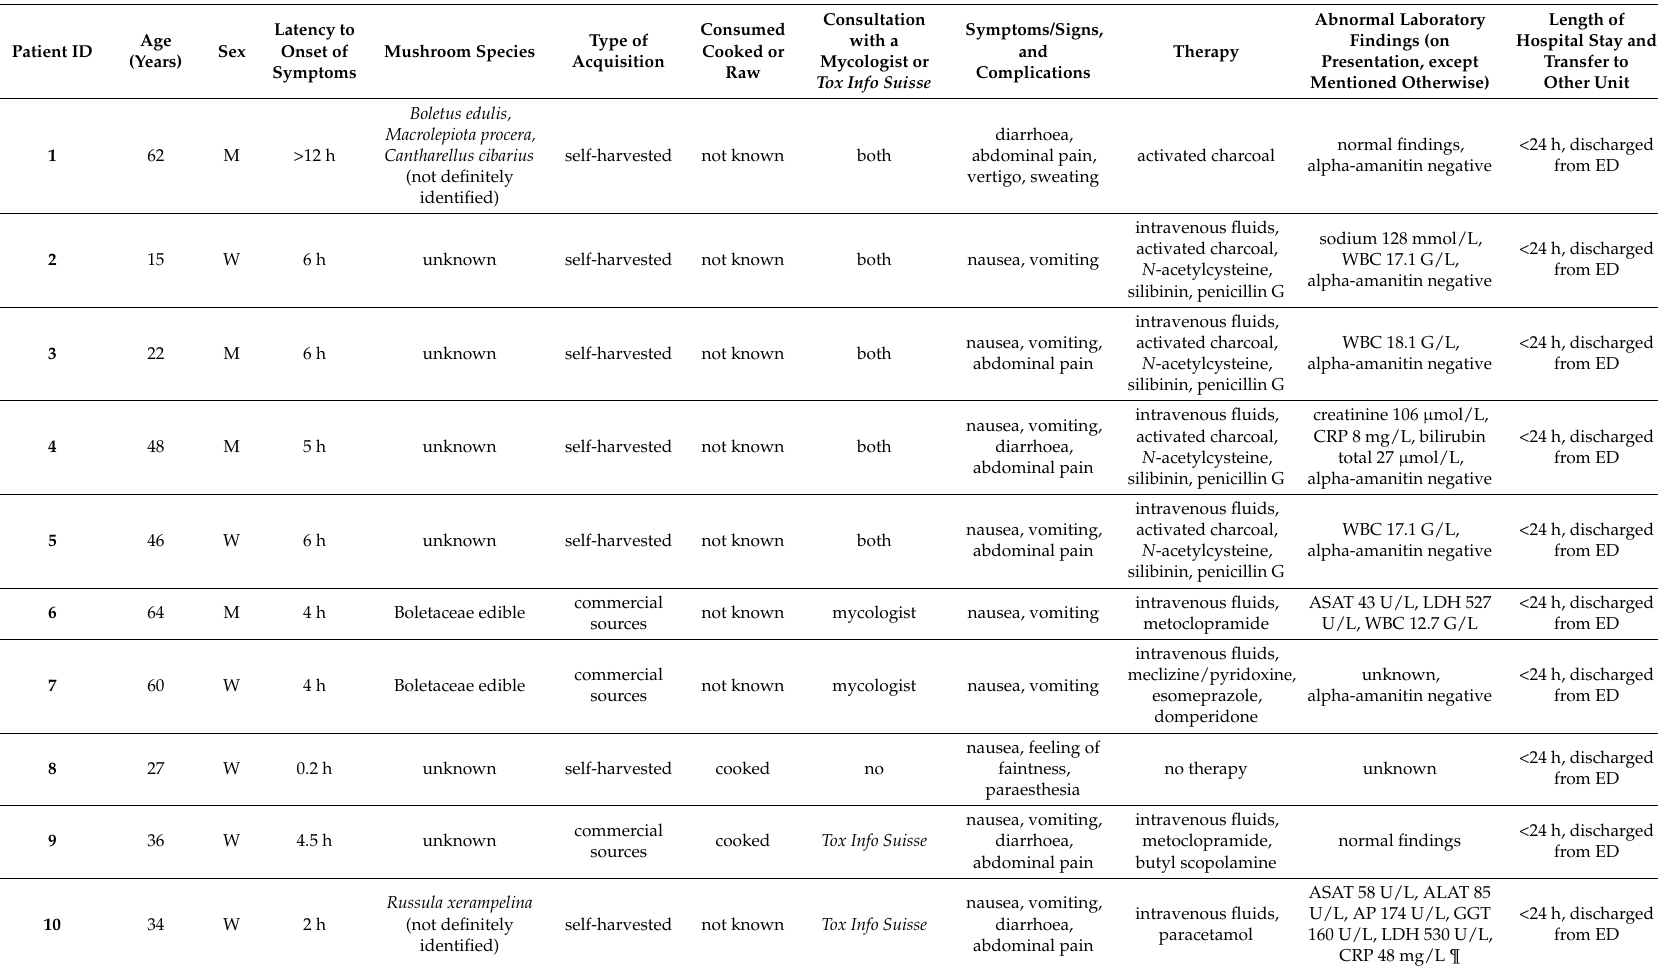
Table 1. Characteristics of cases presenting due to (suspected) mushroom poisoning, 2001–2017 (N =